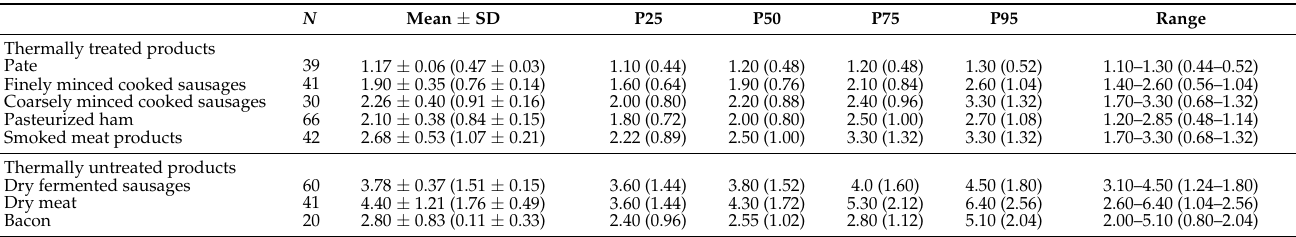
Table 1. Salt (sodium) content in meat products, g/100